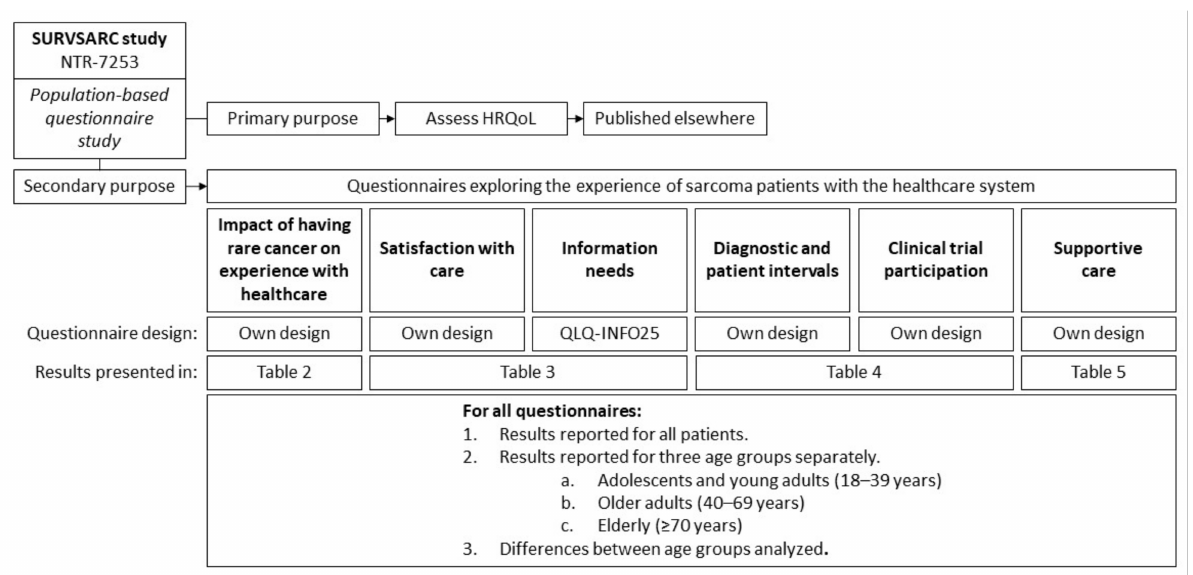
Figure 1. Overview of the design and measures from the SURVSARC study used in this manuscript. HRQoL: Health- related quality of life. QLQ-INFO25: European Organization for Research and Treatment of Cancer Quality of Life Group information